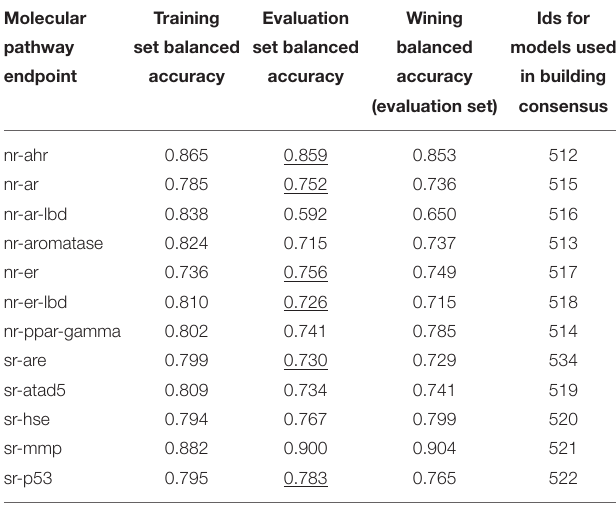
TABLE 4 | Performance of the consensus models with the highest training set balanced accuracy for each pathway endpoint.